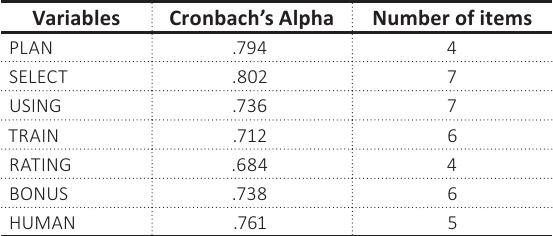
Table 1. Reliability statistics